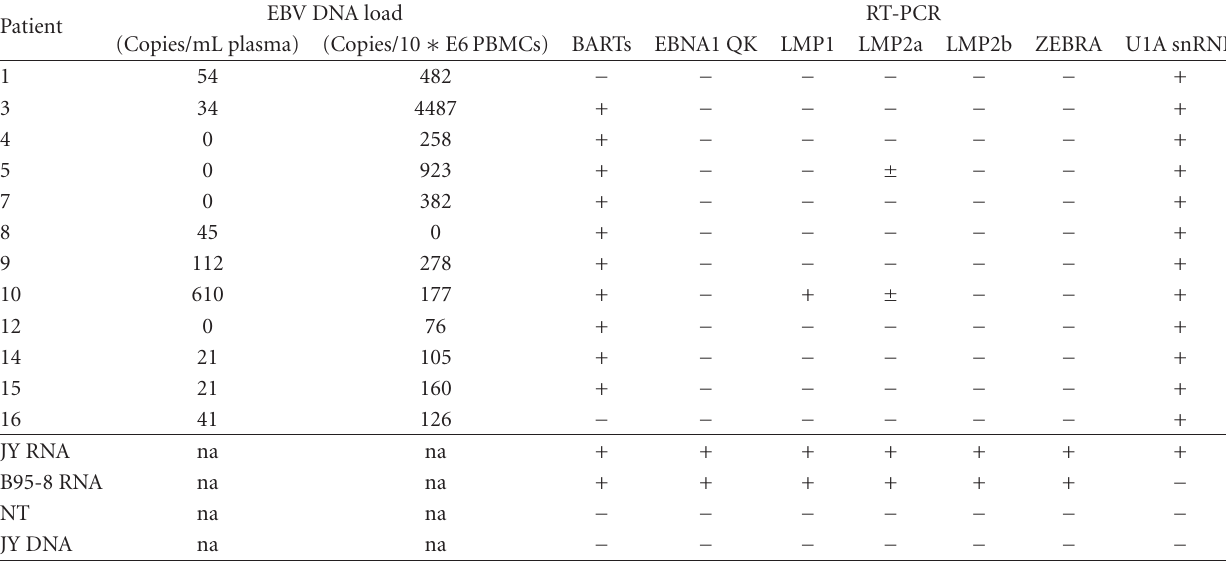
Table 3: RNA profiles in circulation of SOT patients with chronic high EBV loads without PTLD. EBV DNA load and RNA profiles were analysed in PBMCs. JY and B95-8 are EBV infected B cells with latency 3, which served as positive controls for RNA